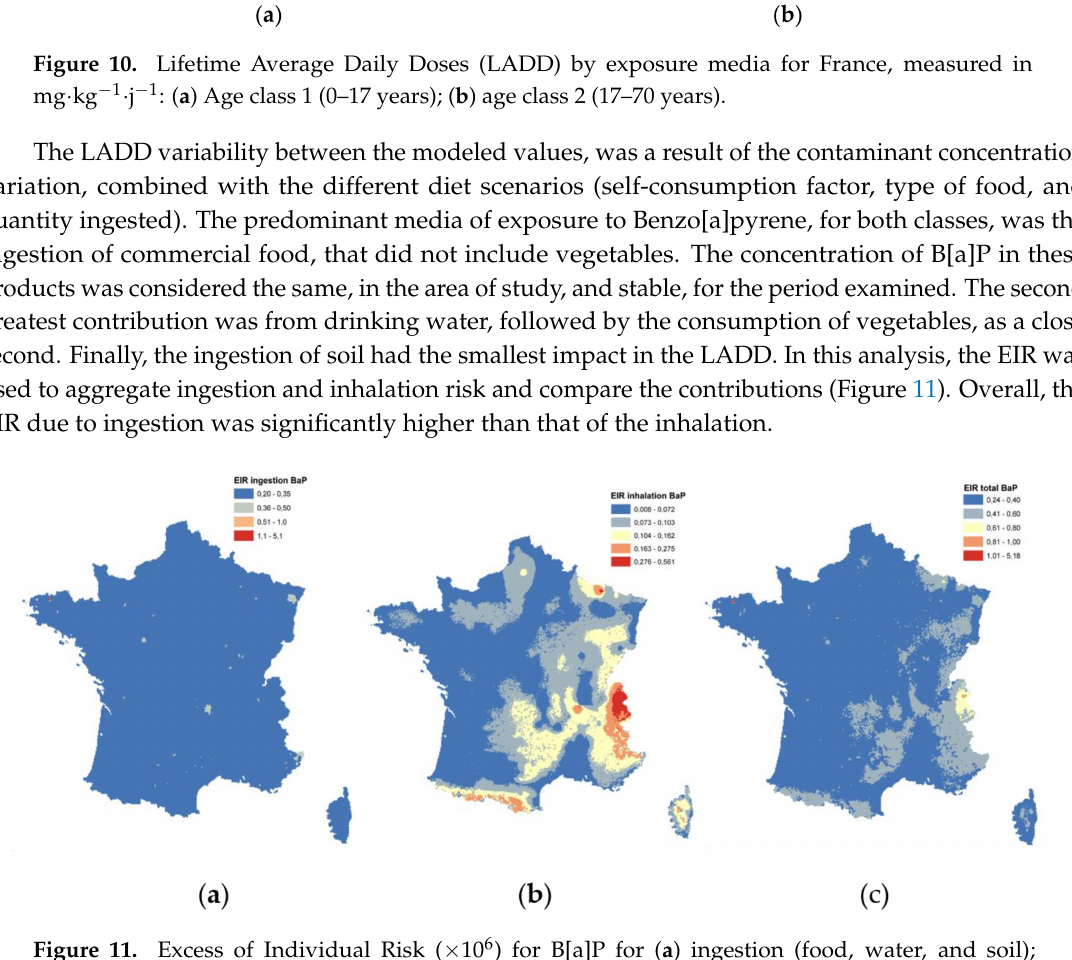
Figure 11. Excess of Individual Risk ( × 10 6 ) for B[a]P for ( a ) ingestion (food, water, and soil); ( b ) inhalation, and ( c ) total in